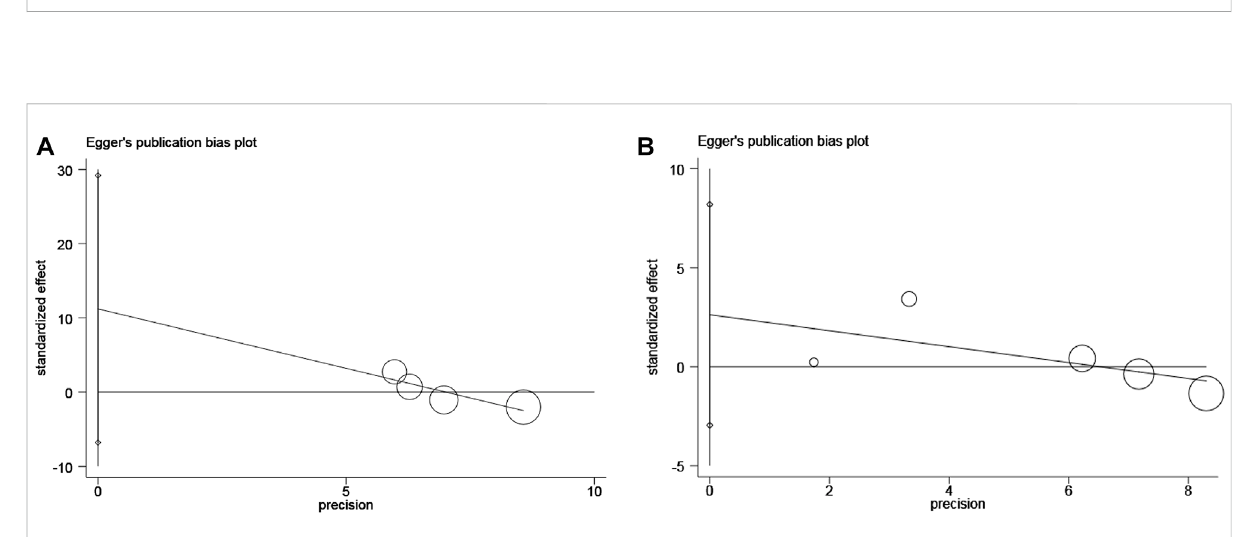
FIGURE 8 Egger ’ s test of publication bias (A) for progression-free survival and (B) for overall